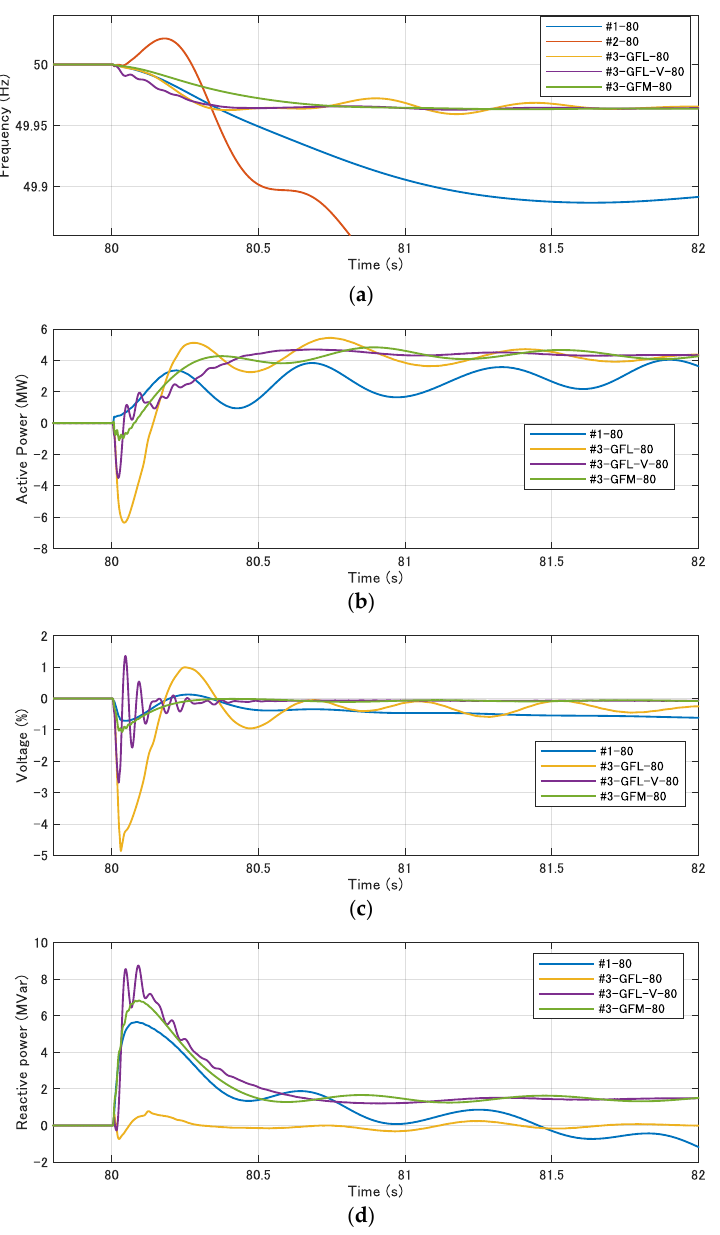
Figure 10. Simulation results of the cases for the 80% IBR penetration rate. ( a ) COI frequency, ( b ) the deviation of the active power output of S3, ( c ) the deviation of the voltage at the POI of the IBR, and ( d ) the deviation of the reactive power output of